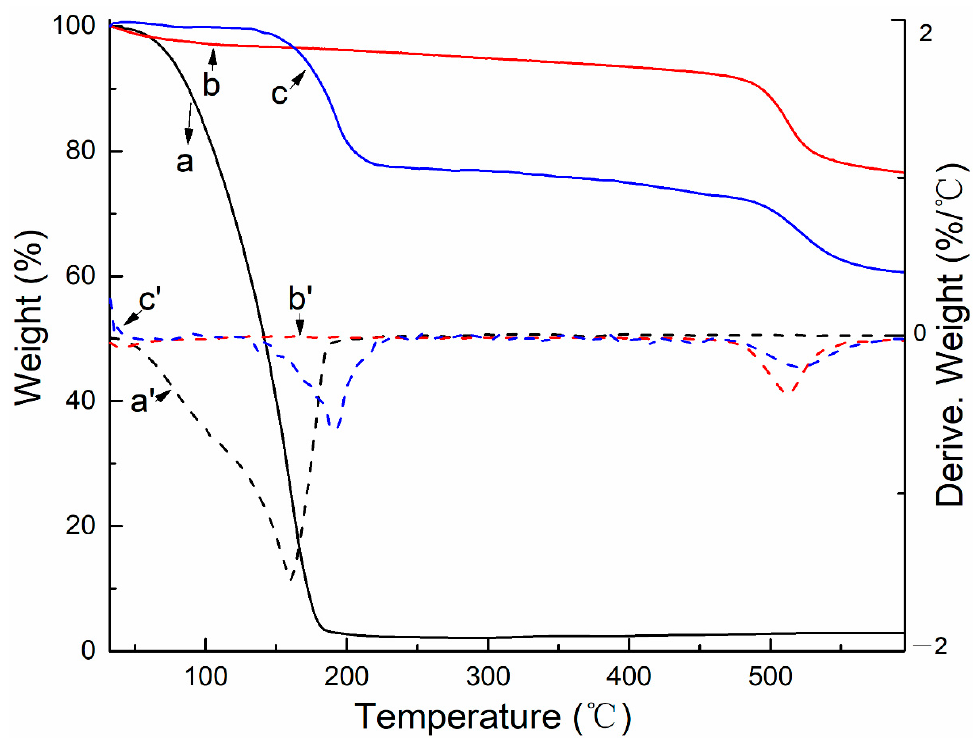
Figure 7. TG and DTG curves of SEO ( a , a’ ), organic hollow mesoporous silica ( b , b’ ) and organic hollow mesoporous silica SEO microcapsule ( c , c’ ),